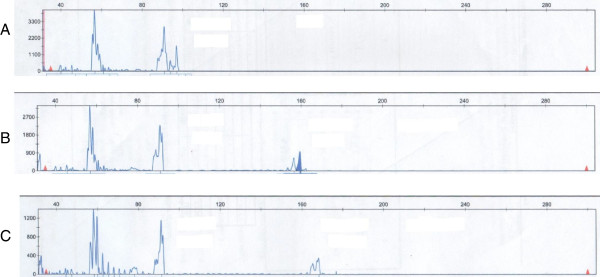
Electrophoretogram of a patient at risk for HD. Several shadow bands can be seen around the main allele bands, but based on the intensity measurement the main bands can easily be determined. The internal size control (not shown) allows the accurate sizing of CAG repeat numbers. In this figure A, B and C depict a non-affected individual, a reduced penetrant CAG repeat mutation carrier and a fully penetrant CAG repeat mutation carrier. Bands with 90, 159 and 168 bp were detected and belong to 15, 38 and 41 CAG repeat numbers respectively.